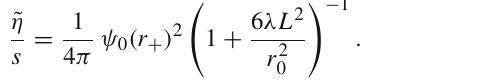
Fig. 1 Global behavior of ˜ η/ s as a function of the temperature for GR BHs. Left panel : neutral AdS BHs. The solid line is the region above the critical radius and the dotted line represents (part of) the region below the critical radius, where the BH is unstable and a thermal AdS solution is preferred; the dot marks the critical radius at T =